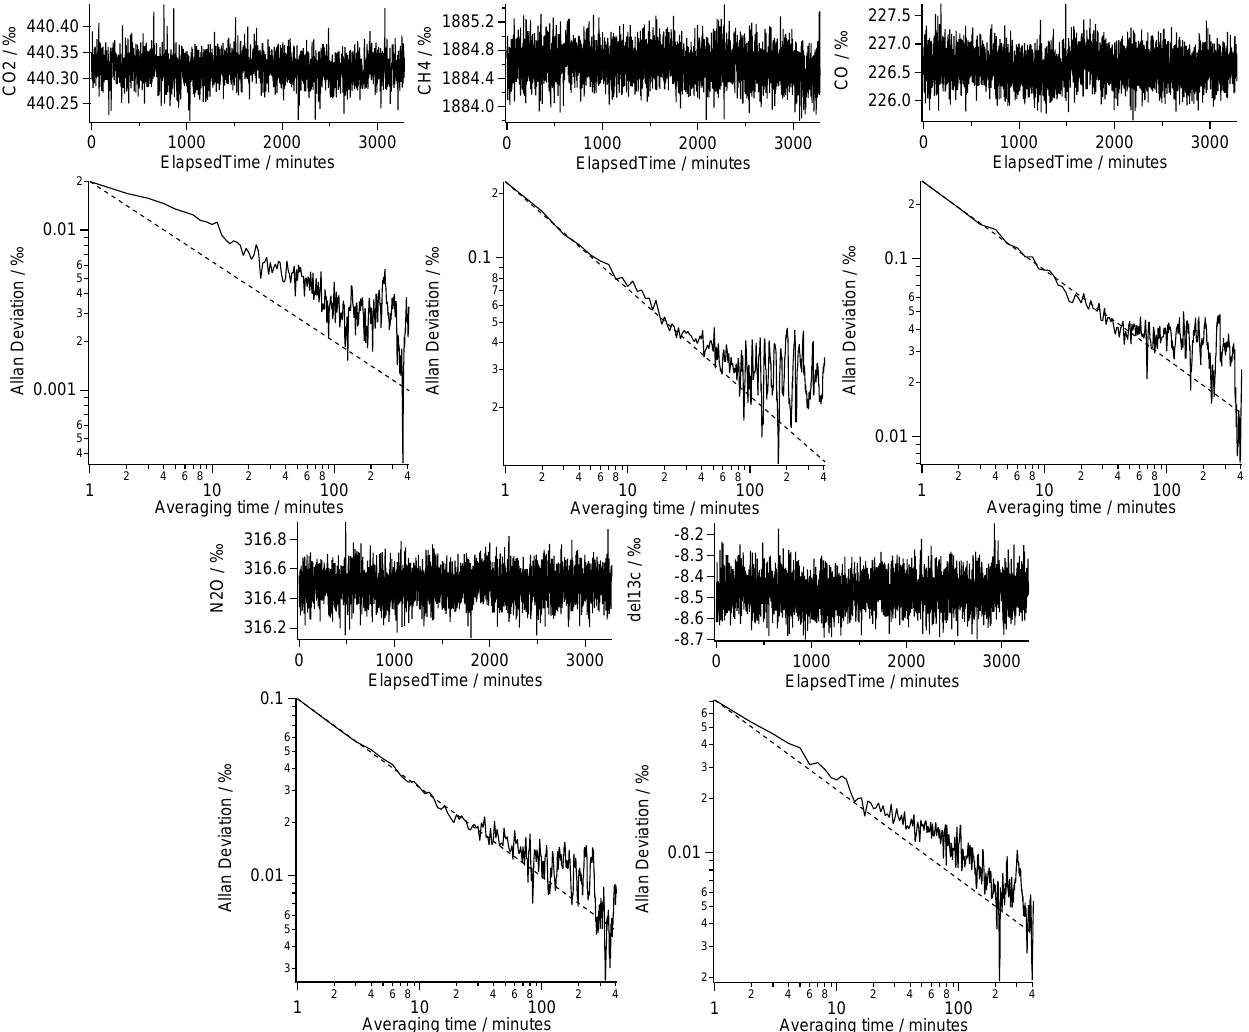
Fig. 4. Time series (upper panels) and Allan deviation (lower panels) plots of consecutive 1-min average measurements of CO 2 , CH 4 , CO, N 2 O and δ 13 C in CO 2 for an unchanging air sample in the FTIR analyser. The dashed lines have a slope of − 0.5 (log-log) and show the expected behaviour of the Allan deviation vs. time for random (white)